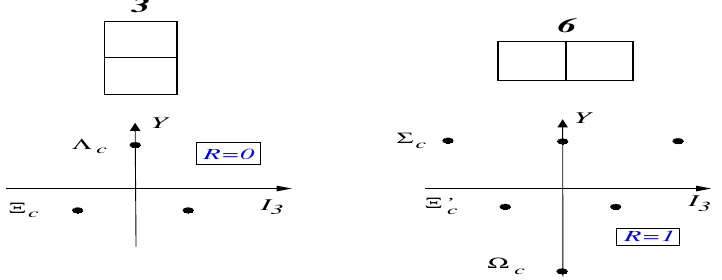
Figure 4. SU ( 3 ) representations for the diquark content of ordinary heavy